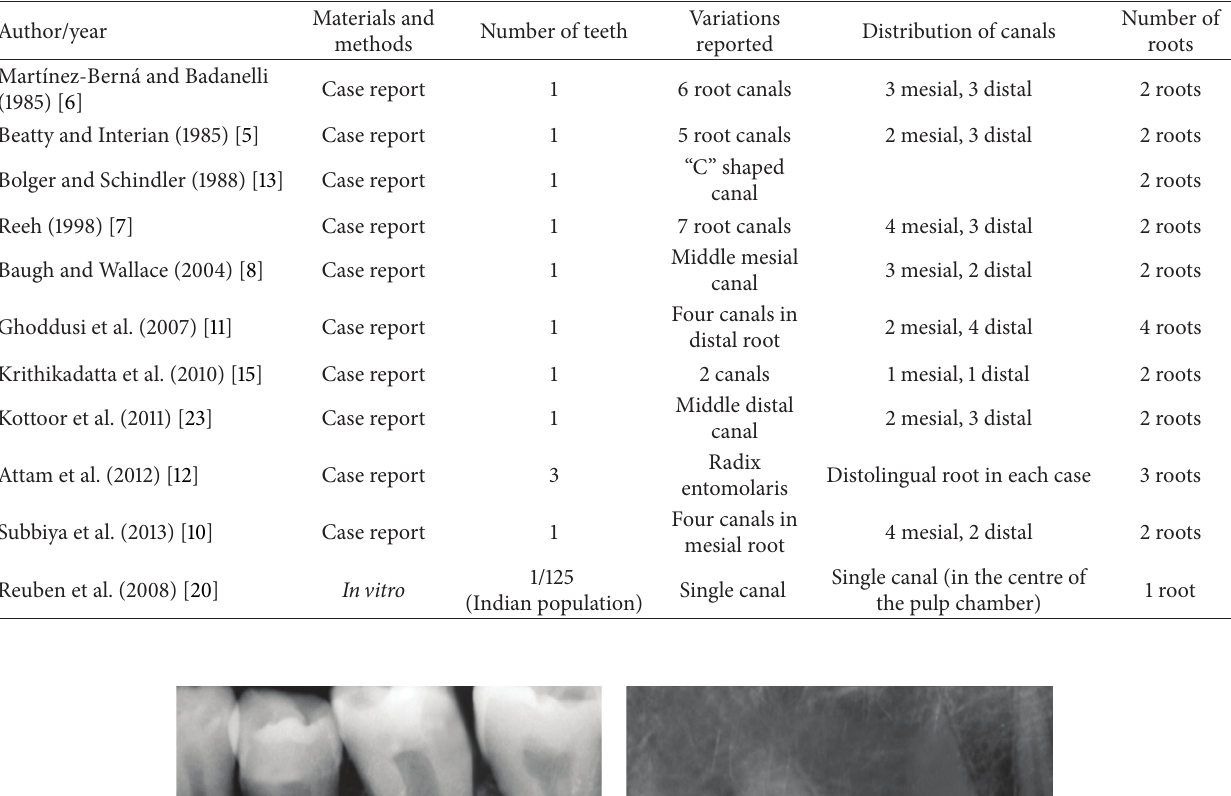
Table 1: The variations in mandibular first molar according to different authors.